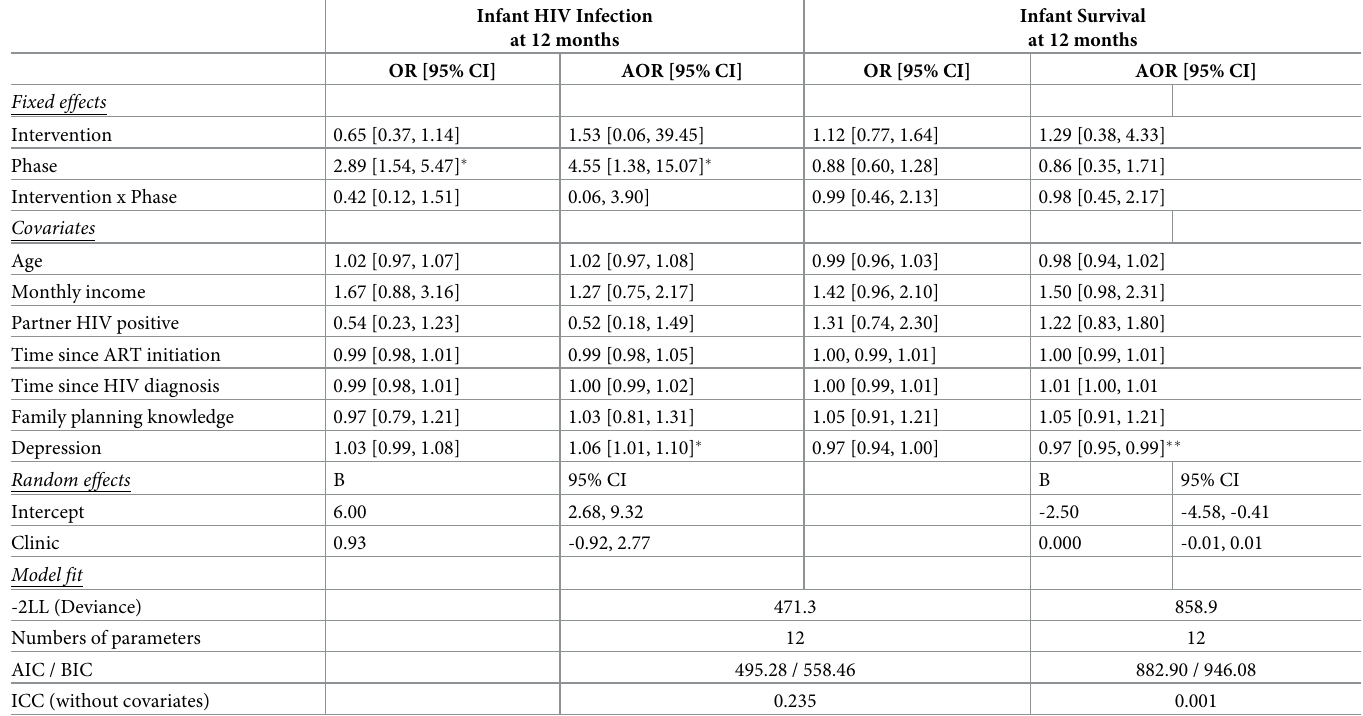
Table 2. Intervention effects on infant HIV infection and survival status (N =